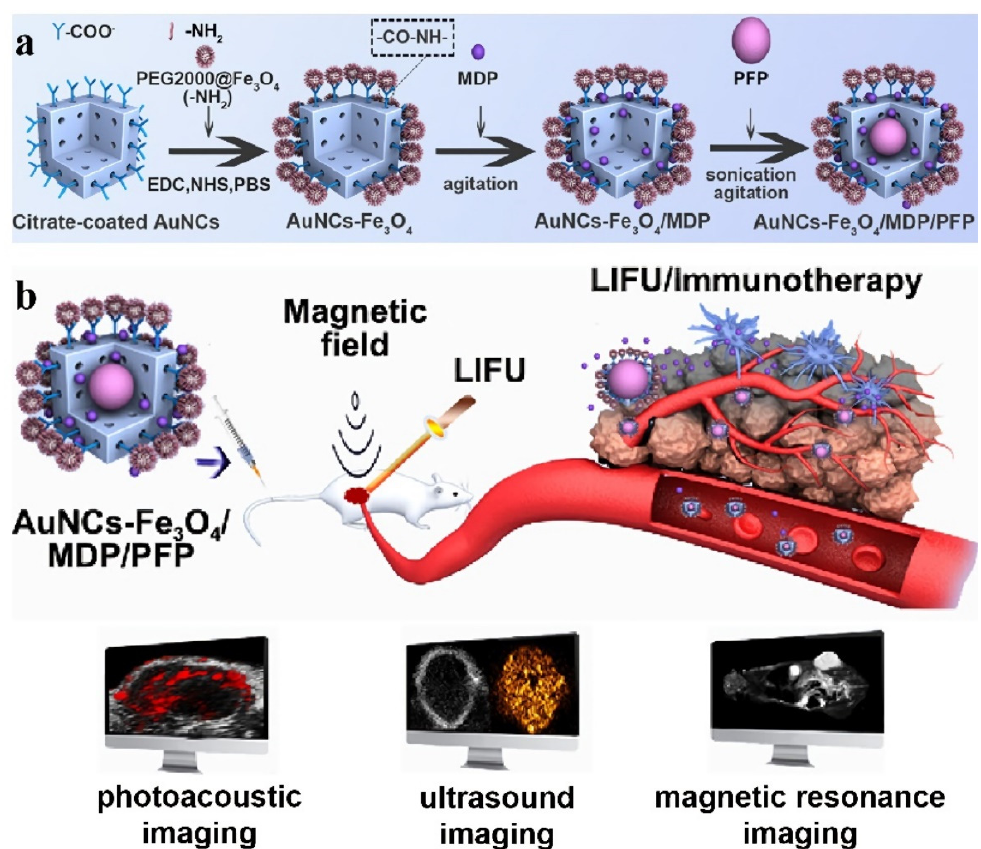
Figure 7. ( a ) Fabrication process of AuNCs-Fe 3 O 4 /MDP/PFP; ( b ) schematic illustration of AuNC- Fe 3 O 4 /MDP/PFP nanoparticles for multimodal imaging-guided LIFU/immunosynergistic therapy of retinoblastoma. Reprinted/adapted with permission from Ref. [80]. Copyright 2020, American Chemical Society.